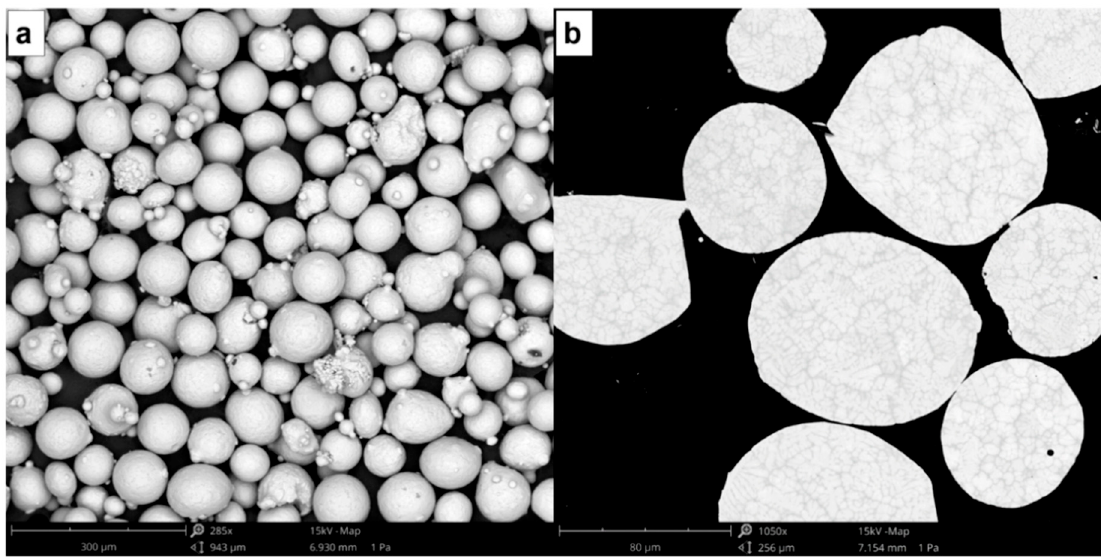
Figure 2. SEM micrographs of spherical pre-alloyed Ti-42Nb powder used as precursor material to generate the specimens: ( a ) particle size and morphology, and ( b ) microstructure.